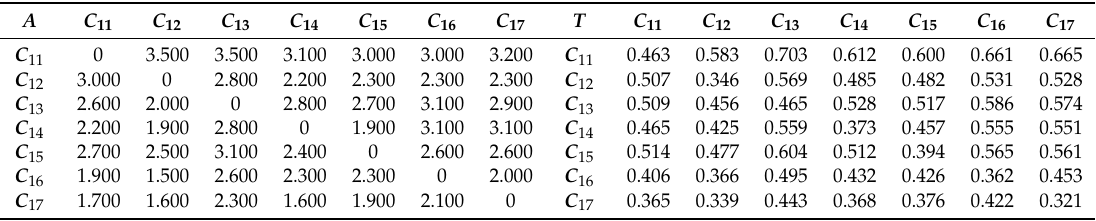
Table 2. The Average-direct influence relation matrix and total influence relation matrix of criteria in D 1 .